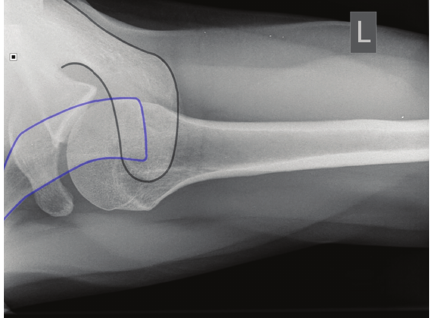
Figure 8: Axillary view radiograph taken 3 weeks after initial injury with the black blue lines illustrating the acromion and calvicle, respectively, confirming the direct superior position of the clavicle in relation to the